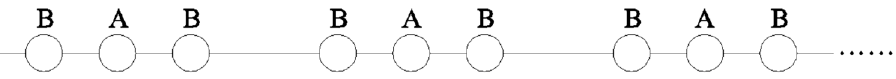
Figure 1. TSC fracture blasting circuit (A refers to PBH and B refers to